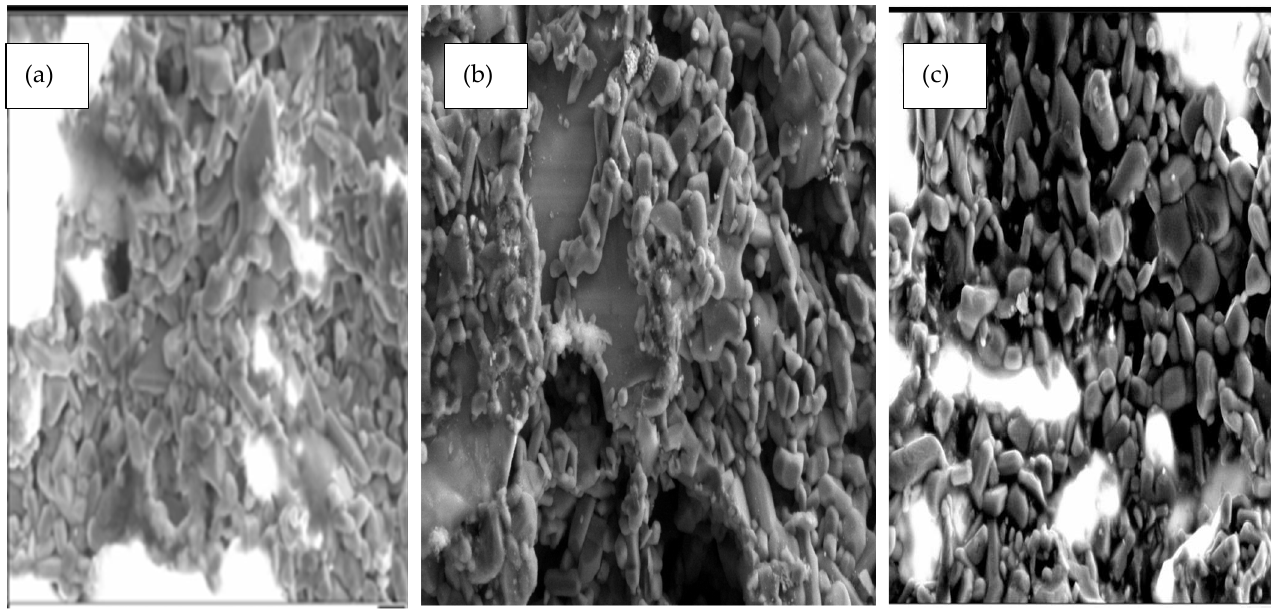
Figure 1. Outer surface SEM micrograph of ( a ) 15 nm membrane ( b ) 200 nm membrane ( c ) 6000 nm membrane.